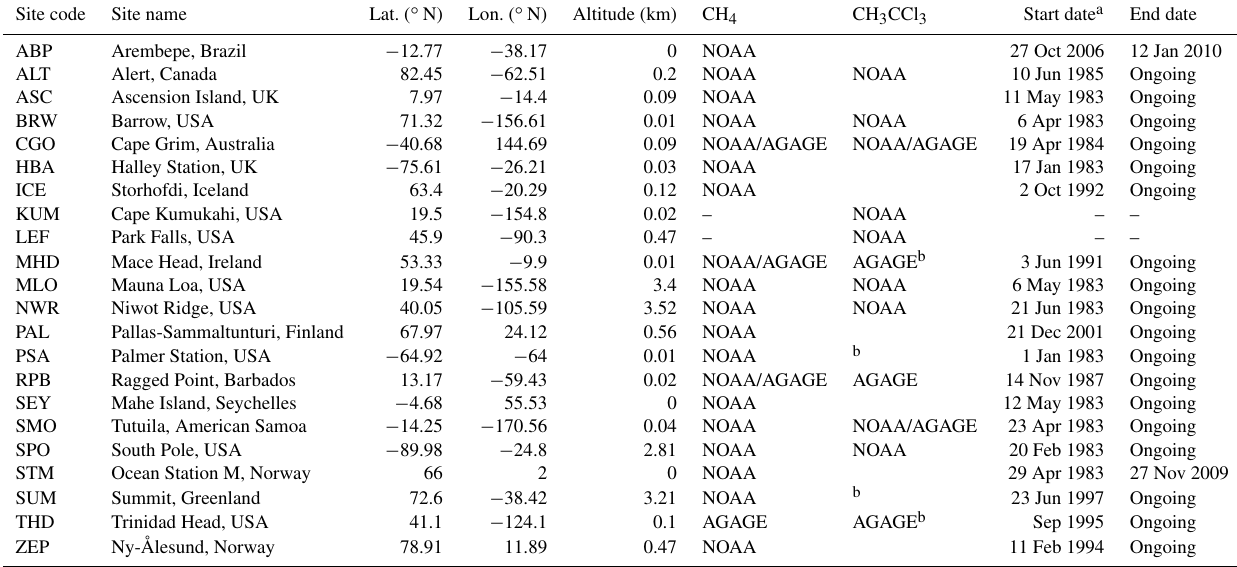
Table 1. List of NOAA and AGAGE stations which provided CH 4 and CH 3 CCl 3 observations. Site code